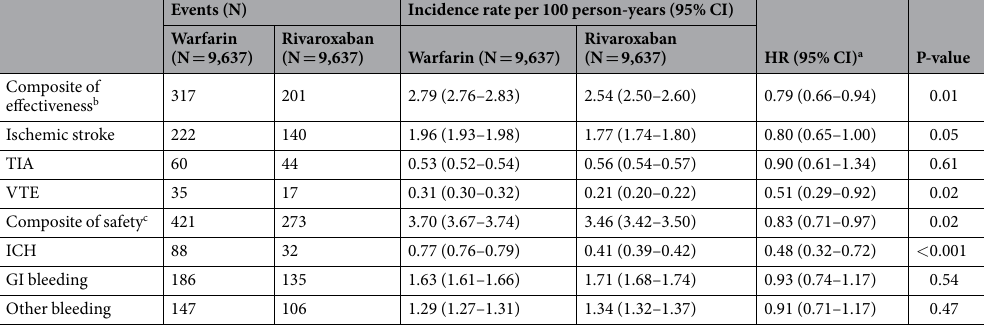
Table 2. Event numbers, incidence rates, and hazard ratios comparing effectiveness and safety outcomes of warfarin and rivaroxaban use. a Hazard ratios were estimated by the Cox proportional hazard model with the warfarin group serving as a reference. Propensity-score matching hazard ratios were controlled by age, sex, annual stroke risk, history of ischemic stroke/systemic embolism, TIA, VTE, acute myocardial infarction, heart failure, hypertension, renal disease, liver disease, diabetes mellitus, peptic ulcer disease, peripheral vascular disease, ICH, GI bleeding, coagulation deficiency, use of antiplatelet, proton pump inhibitors, histamine-2 receptor antagonists, antacids, non-steroid anti-inflammatory drugs, antiarrhythmic drugs, digoxin, beta- blockers, calcium channel blockers, angiotensin converting enzyme inhibitors/angiotensin receptor II blockers, statins, and anti-diabetes drugs. b Composite of effectiveness was the outcome of a composite of ischemic